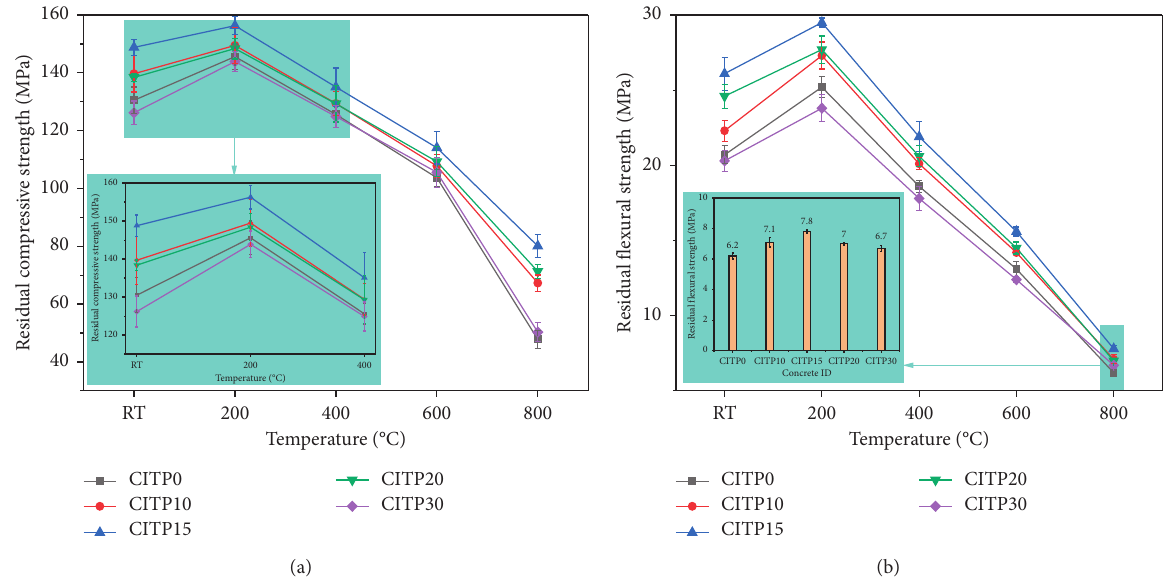
Figure 4: Residual strength of concrete: (a) residual compressive and (b) residual flexural